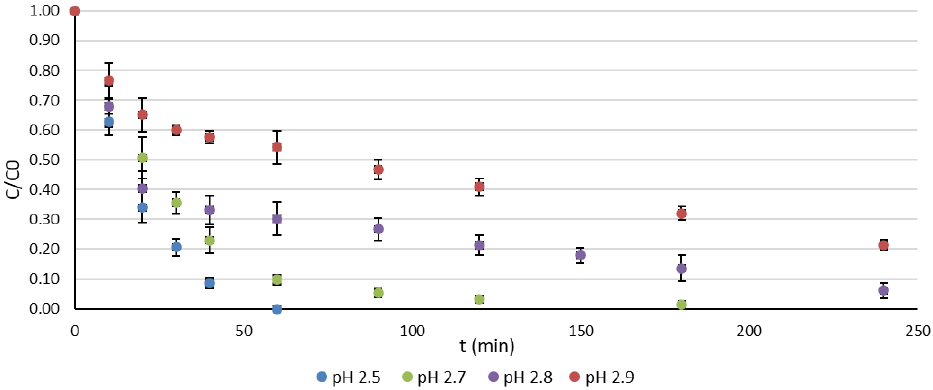
Figure 8. Duplicates of solution of C 0 = 15 mg/L Cr(VI), 5 mM citric acid and 1.2 g catalyst/L, in dark conditions and different pH values. dark conditions and different pH values.